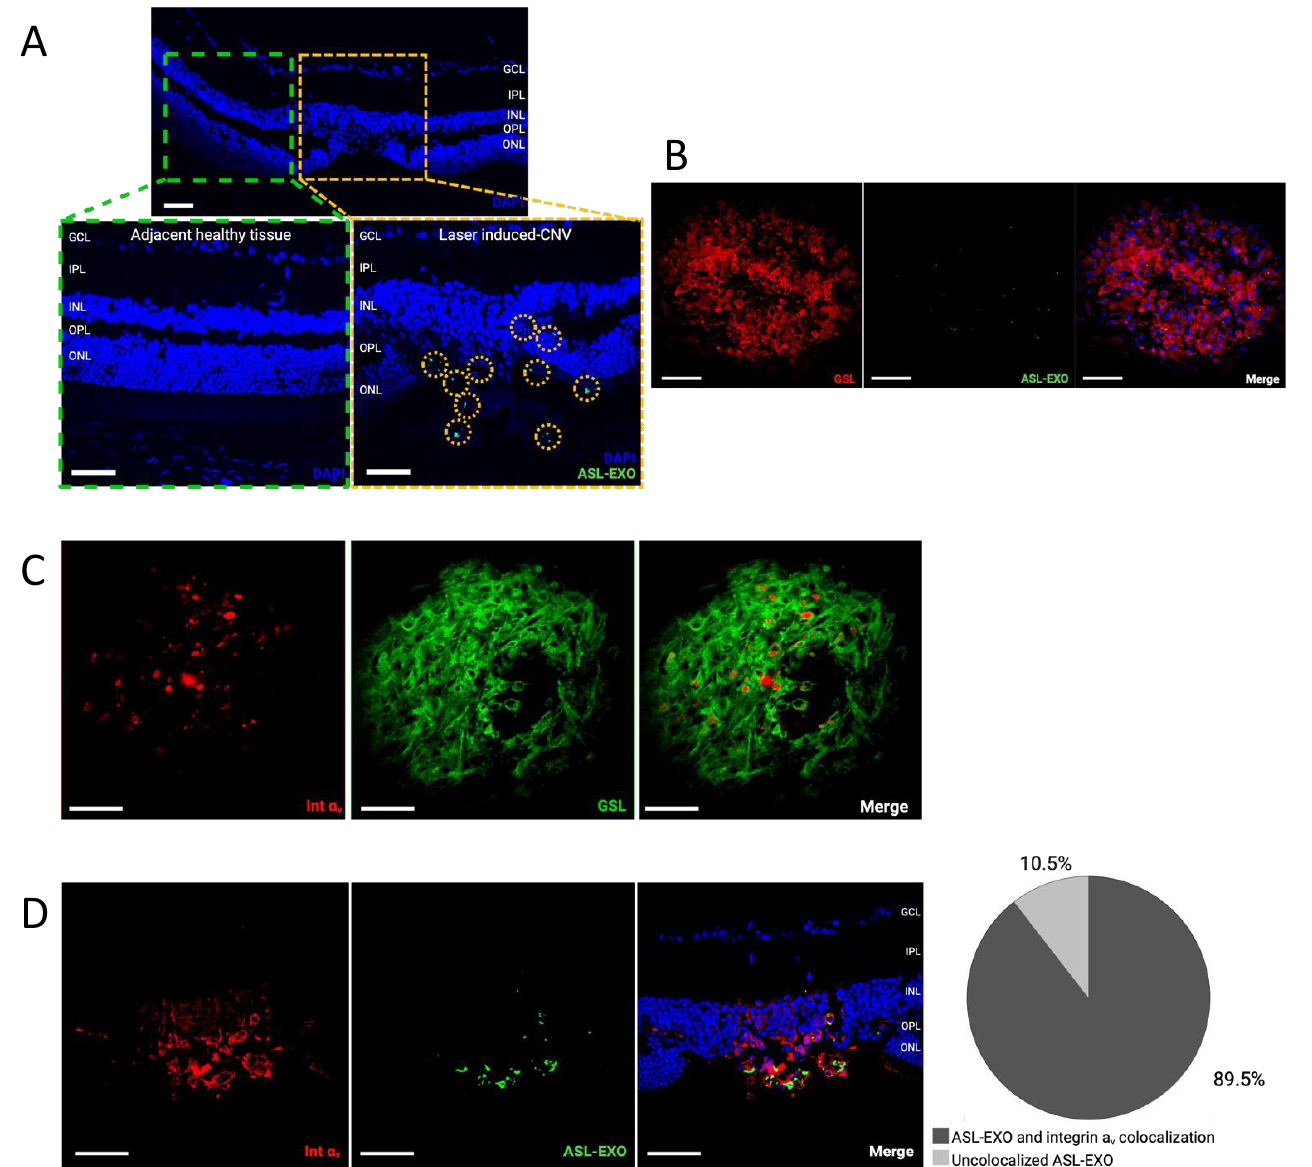
Figure 5. Intravitreally injected ASL exosomes were primarily delivered to the site of CNV. Intravitreal injection of ASL exosomes (1 μL) was given 3 days after laser treatment in a mouse model of CNV and the eyes were harvested 7 days after injection to obtain retinal sections (8 μm) and RPE/choroid flat-mounts. Representative eye sections showing ASL exosomes (green) exclusively delivered to the area of CNV ( A ). Representative RPE/choroid flat-mount of a CNV area showing ASL exosomes (green) delivered to the newly formed vessels (rhodamine-conjugated GSL, red) ( B ) and increased integrin α v expression (red) within CNV area (rhodamine-conjugated GSL, green) ( C ). The ASL exosomes (green) are colocalized with integrin a v (red) with 89.5 % of overlapping (n = 3) ( D ), scale bar, 100 μm.